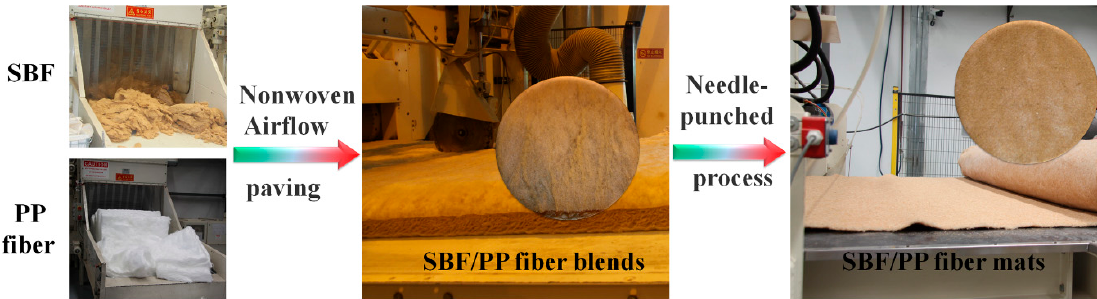
Figure 2. Graphical illustration of the mat production from SBFs and polypropylene (PP) fibers.